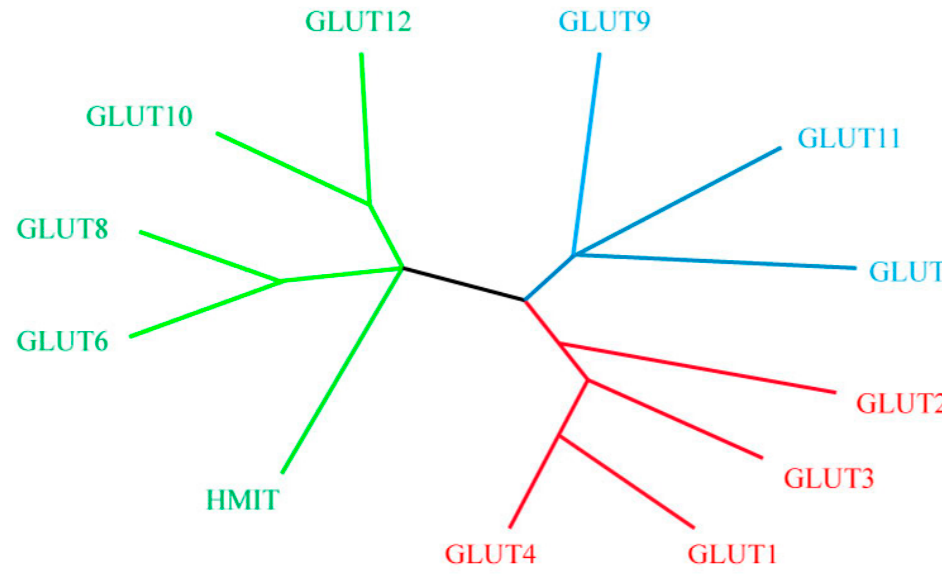
Figure 2. Un-rooted phylogenetic tree of the 12 bovine family members of the Facilitative glucose transporters (GLUTs)1 (Małgorzata et al., 2005)